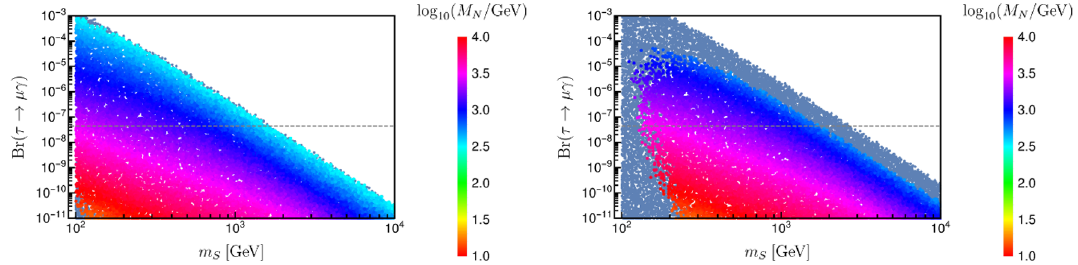
Figure 8 . Calculated values for Br( (cid:28) (cid:22)(cid:13) ) as function of the scalar mass m s for di(cid:11)erent values ! of M N (color coded). Bluish points are ruled out by non-perturbative couplings. To the left, with current experimental limits; to the right for the expected future experimental limit on Br( (cid:22)